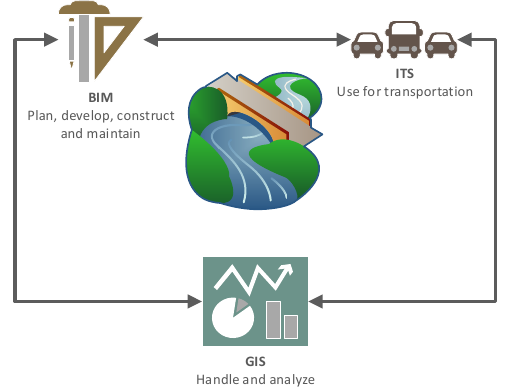
Figure 1. The roles of GIS, ITS and BIM in the digital geospatial